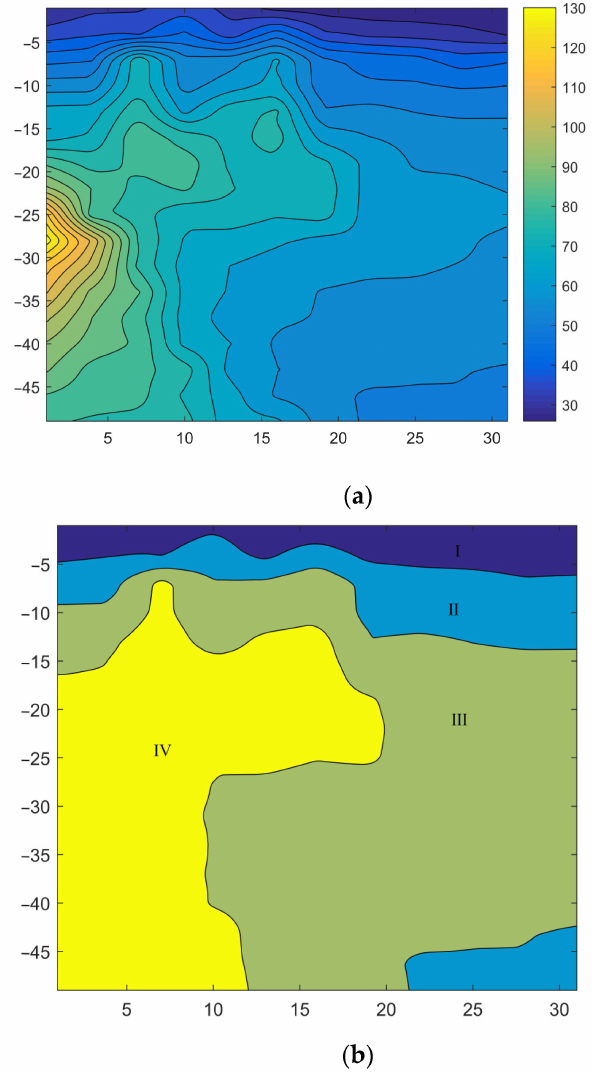
Figure 29. Adjacent influential partition based on surface settlement: ( a ) cloud diagram of variation in the maximum surface settlement and ( b ) schematic diagram of adjacent influential